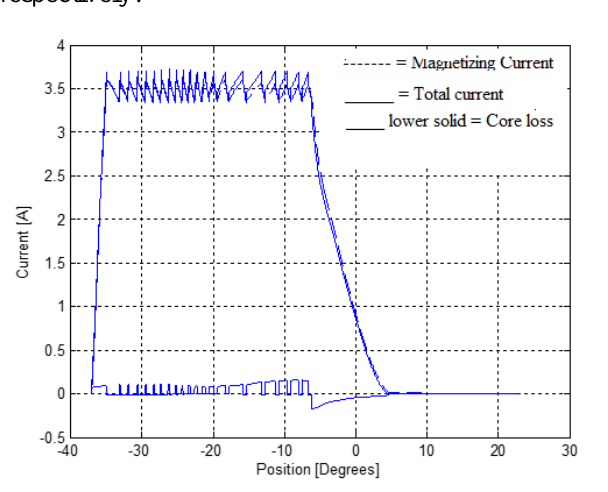
Fig. 11. Representation of current waveforms at conduction angle of 31 0 in current chopping mode